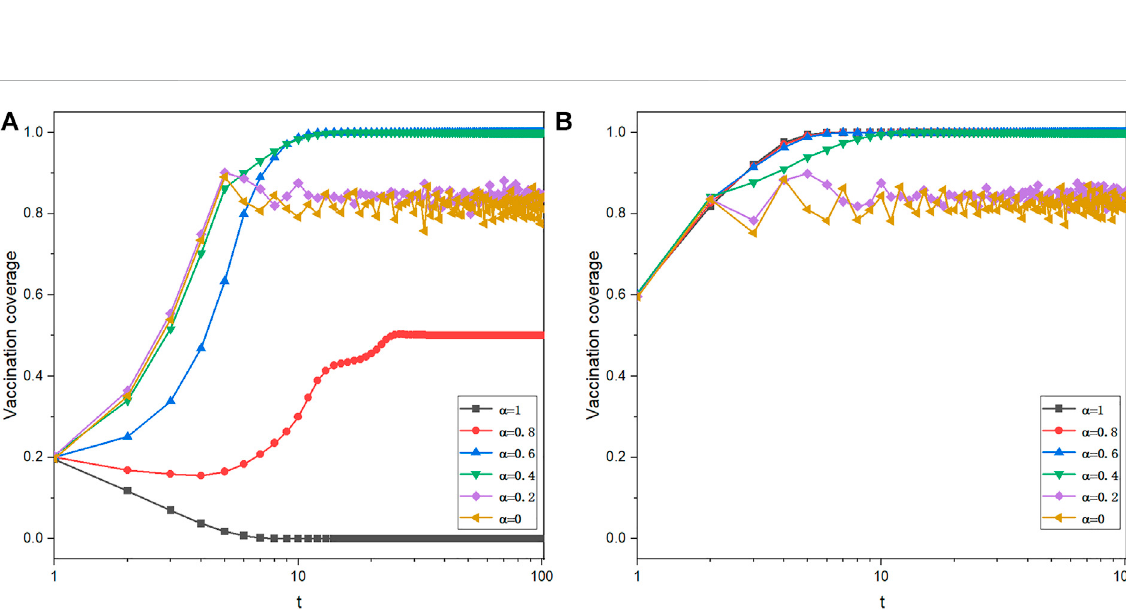
initial vaccination fraction V 0 = 0.2 (Figure 1A), stronger conformity has negative effects on vaccination behaviors. In